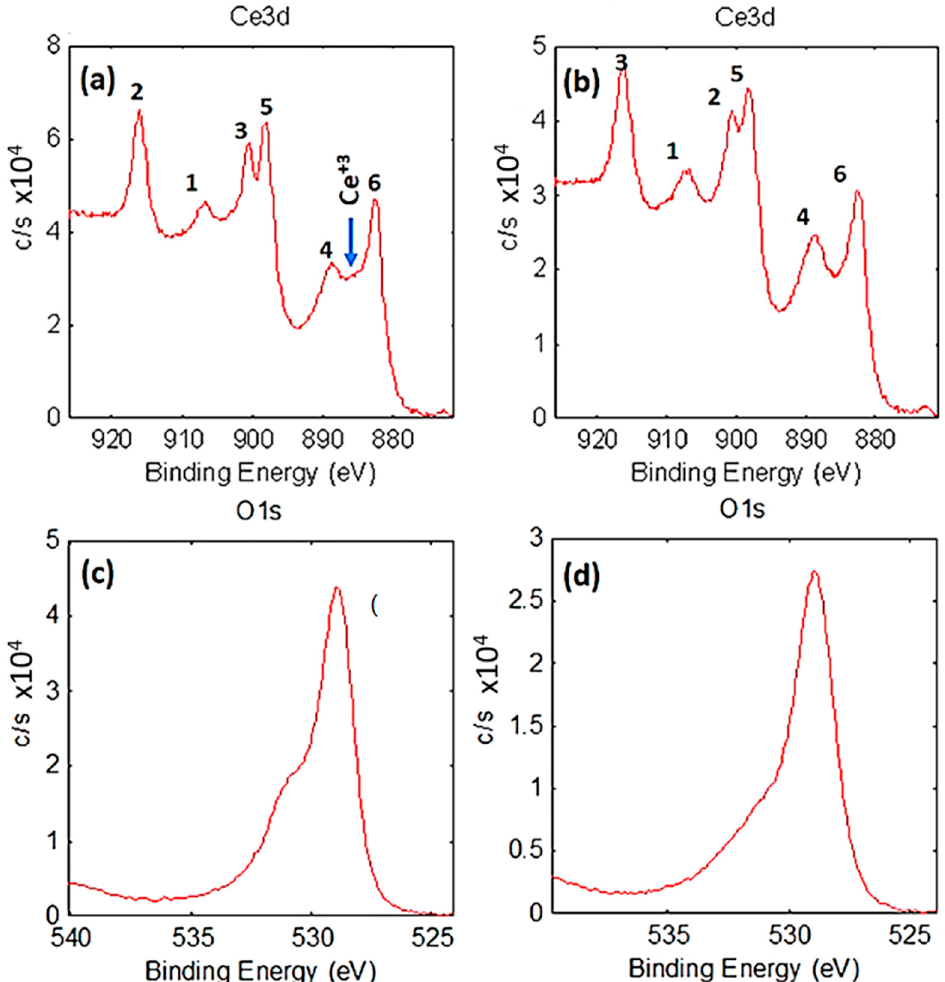
Figure 4. High-resolution of Ce 3d (including respective shake-up and shakedown peaks) and O 1s spectrum of fresh Au/CeO 2 prepared by LVCC ( a , c ) and DP ( b , d ), respectively.